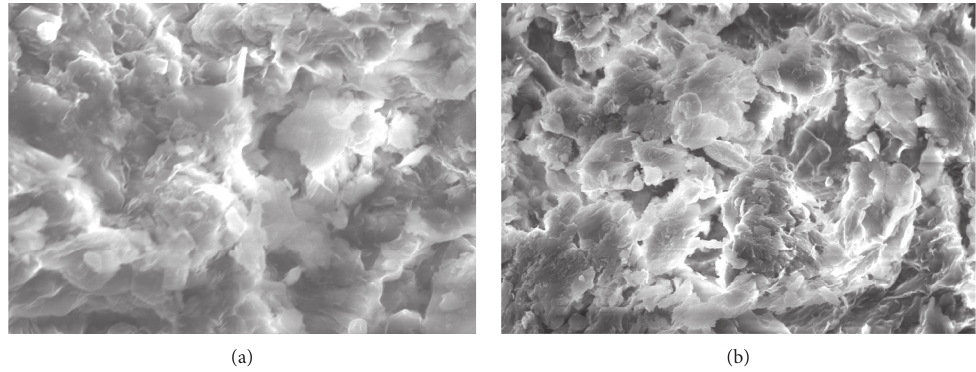
Figure 3: SEM images of rock samples. (a) 5000 times sandy mudstone picture and (b) 5000 times mudstone pictures.